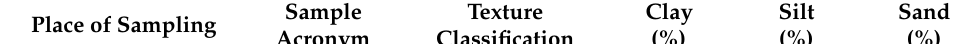
Table 1. Soil classification according to its granulometric composition (clay, silt, and sand contents). Place of Sampling